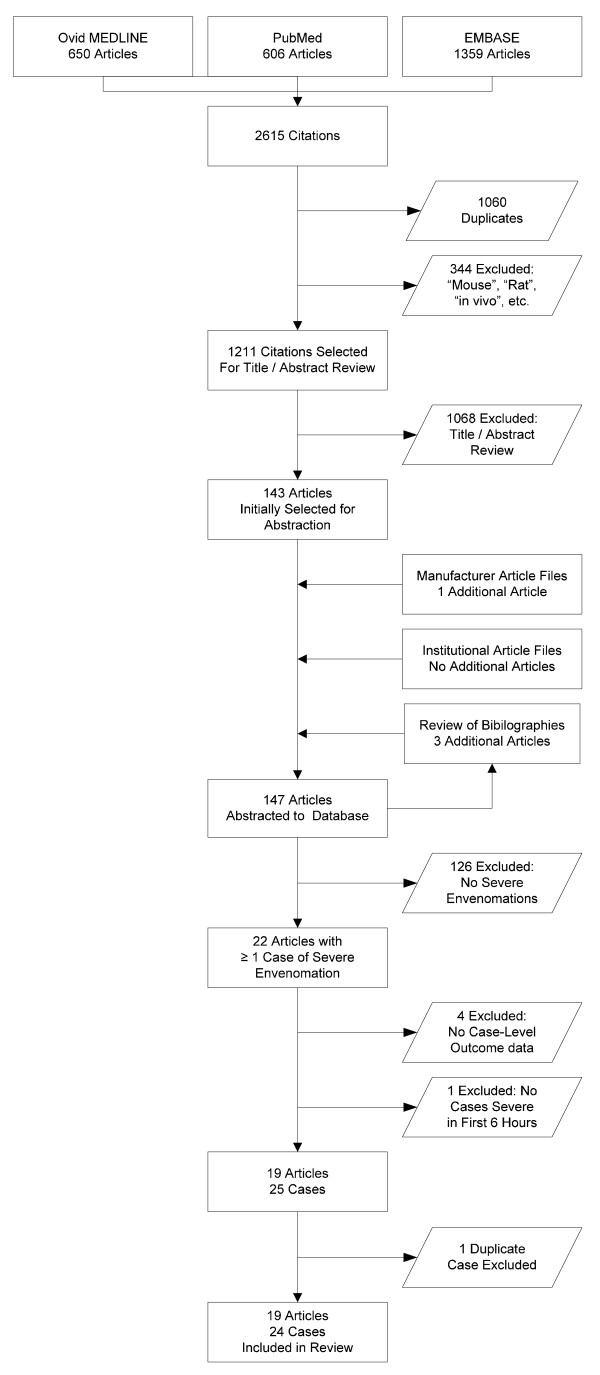
Article identification and selection process. This information is also presented as an attached file.